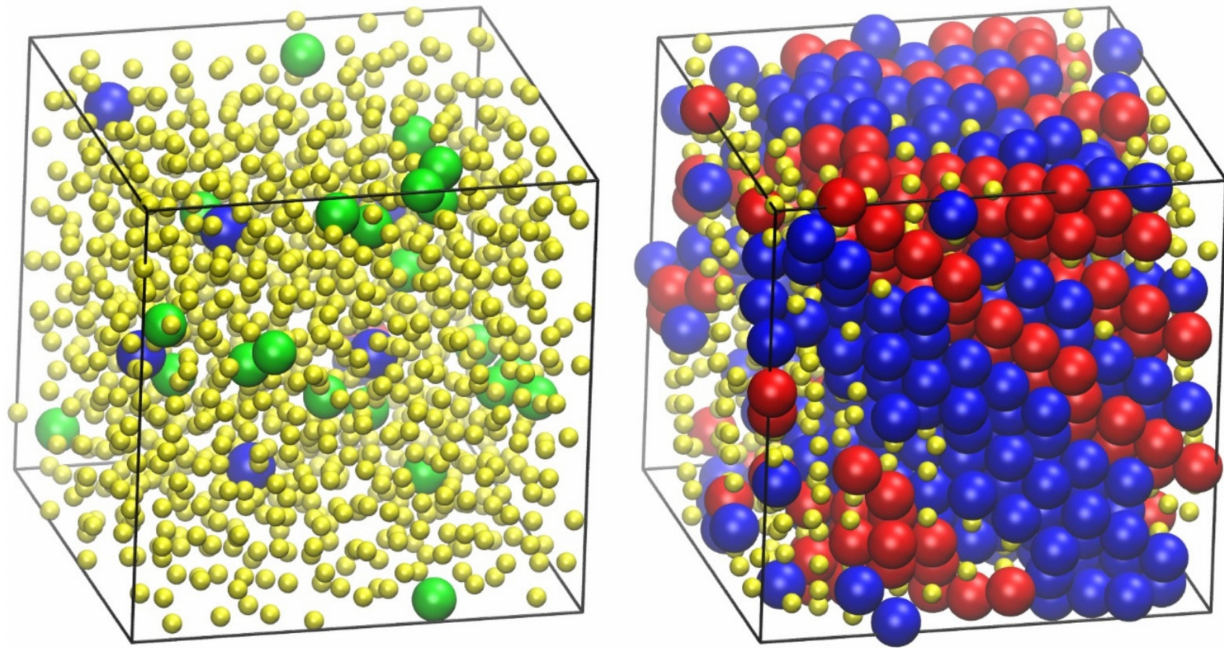
Figure 7. Snapshots of the semi-flexible N = 12 system ( θ 0 = 90 ◦ ) at ϕ = 0.58. ( Left panel ): Initial configuration as produced by the generator module of Simu-D. ( Right panel ): Final configuration of the simulation after the execution of 3 × 10 11 MC steps of the simulator module. Monomers are colored according to the lowest value of the CCE norm (descriptor module). Blue, red, and green colors denote HCP, FCC, and FIV similarity, respectively. Amorphous (AMO) ones are colored yellow with reduced dimensions for clarity. Spherical monomers are shown with coordinates of their centers subjected to periodic boundary conditions. Image created with the VMD visualization software [54]. Figure panels are also available as interactive, 3-D images in Supplementary